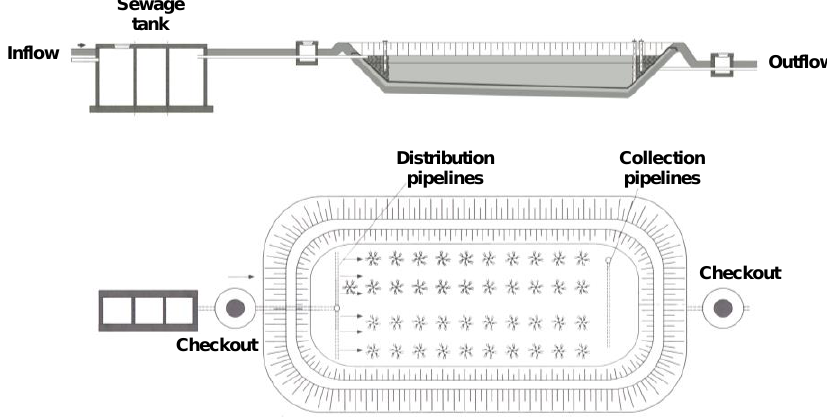
Figure 1. Design of the constructed wetland.